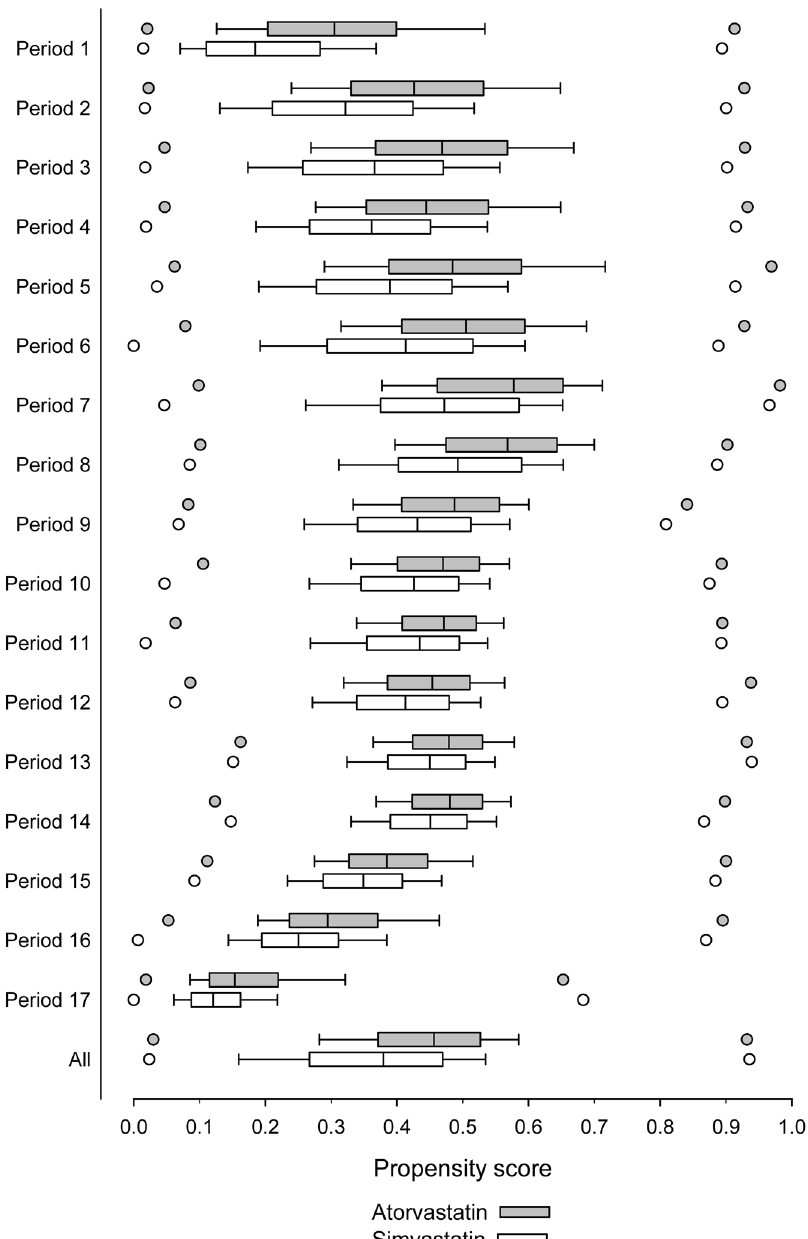
Figure 1. Distribution of propensity scores estimating the effect of initiating statin therapy with simvastatin versus atorvastatin in 1998–2006 in 6-month periods (1 st =from 1 January 1998 to 30 June 1998; 17 th =from 1 January 2006 to 30 June 2006). The boundary of the box closest to zero indicates the 25th percentile, a line within the box marks the median, and the boundary of the box farthest from zero indicates the 75th percentile. Whiskers (error bars) above and below the box indicate the 90th and 10th percentiles. In addition, the lowest and the highest values are presented by points.